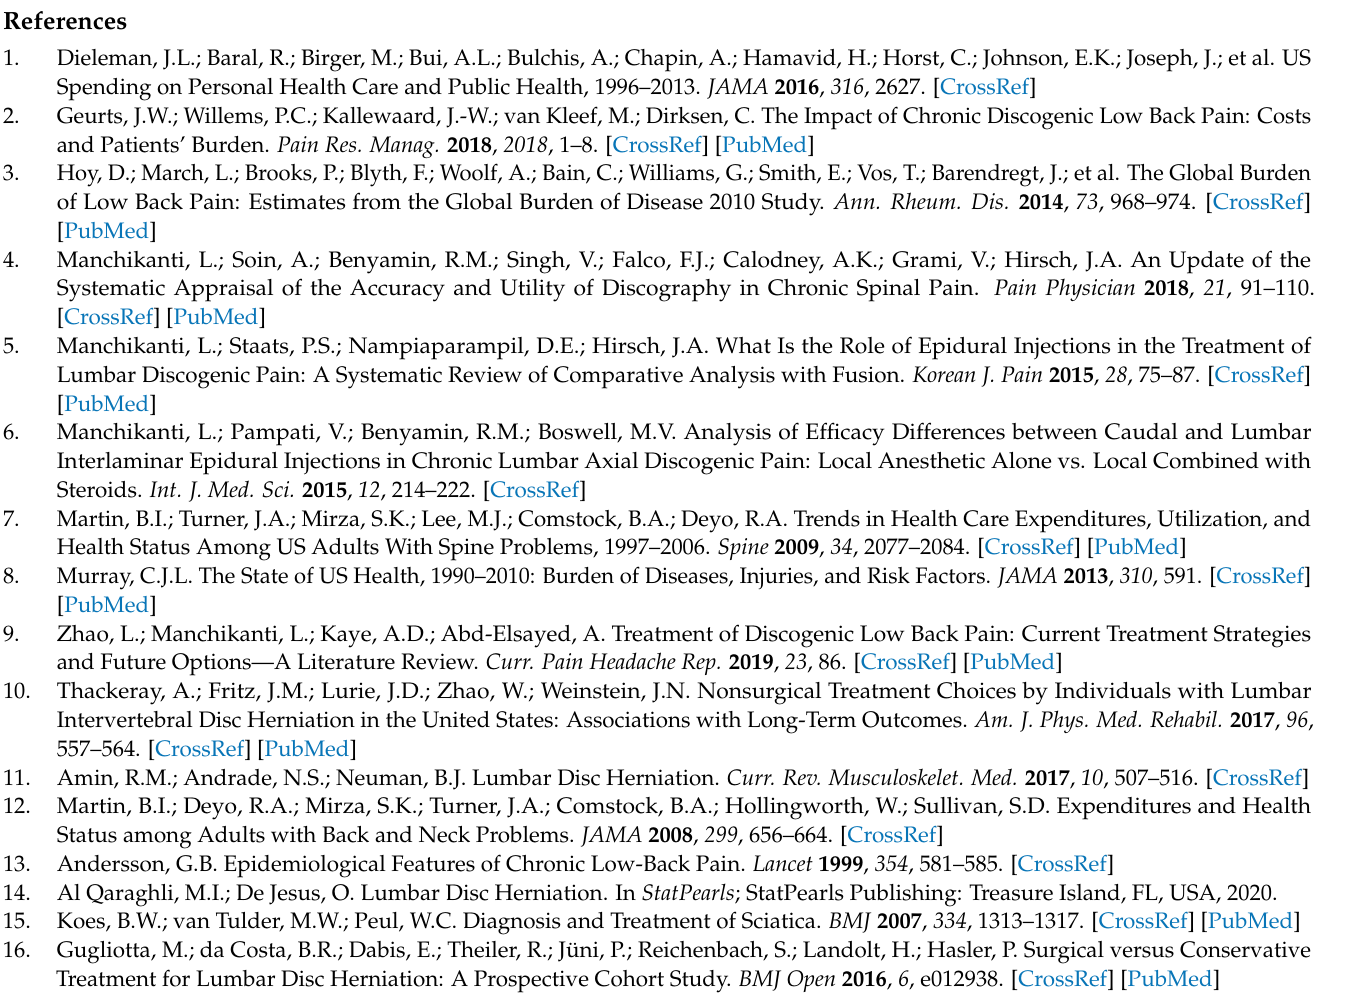
Figure A2. Dislikes were plotted on a log scale due to the typical distribution of this variable. When plotted against the GQS of the corresponding video, an almost horizontal line emerged. A similar picture appears for all other combinations of Likes, Dislikes and Views vs. the quality scores employed in this study. Table A1. Fleiss’ Kappa estimated in order to assess rater agreement was determined to be poor in this data set both overall and for each individual value of GQS.